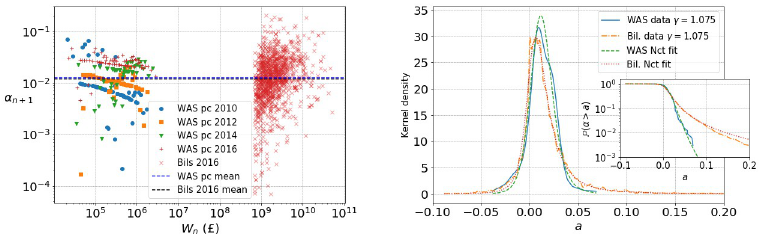
Fig 4. Left: α n +1 (10) for WAS data percentiles [18] for four time periods along with 2016 billionaire data plotted . We choose γ = 1.075 so that the means of WAS and billionaire data essentially agree (dotted lines). against wealth W n Right: Kernel density of α n +1 for WAS data and 2016 billionaire data as seen in the left Figure. Inset: corresponding empirical tails P ð a > a Þ on logarithmic scale. Dotted green and red lines provide fits by the non-central t -distribution n (nct) to WAS and billionaires with respective nct parameter fits k � 6.03, c � 0.0573, l � − 0.00575, s � 0.0112 and k � 2.01, c � 0.941, l � − 0.00156, s � 0.0112.